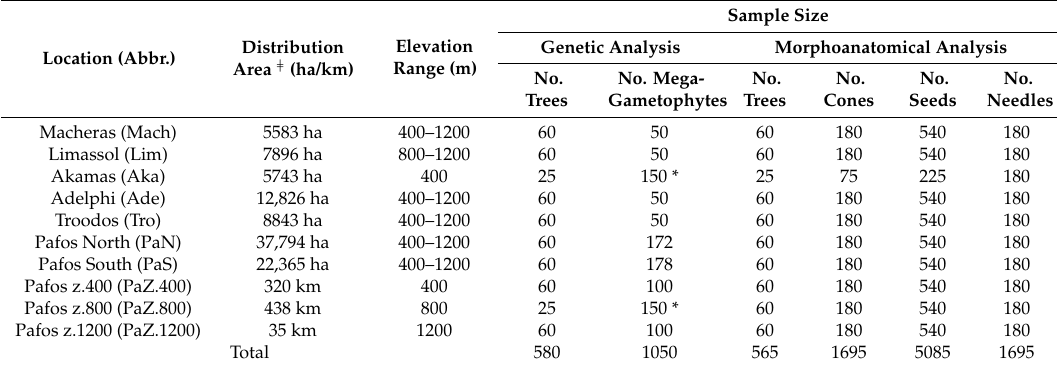
Table 1. Geographic location of samples along the Troodos mountain range and sample size per sampled